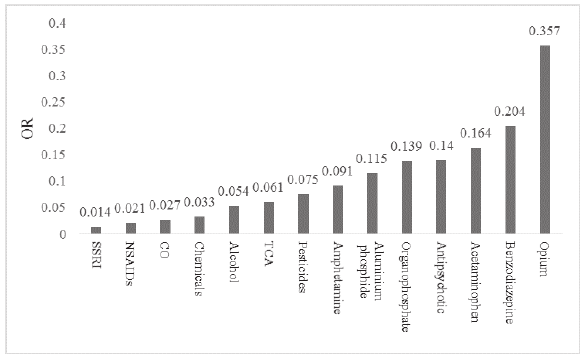
Figure 2. Ranking of each poisoning agent OR.